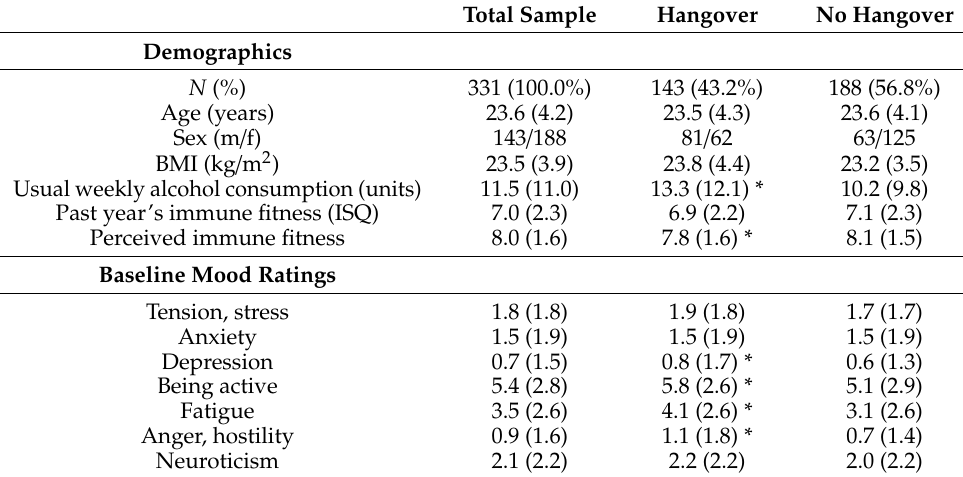
Table 1. Demographics and baseline mood.